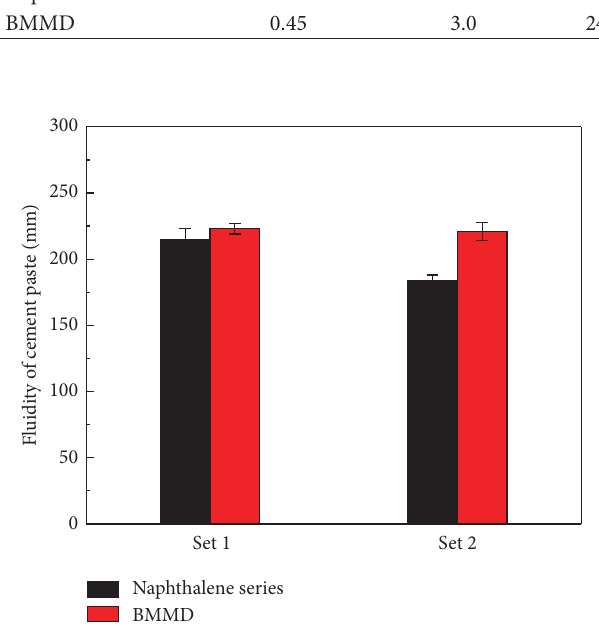
Figure 4: Anticlay performance of BMMD and naphthalene series.